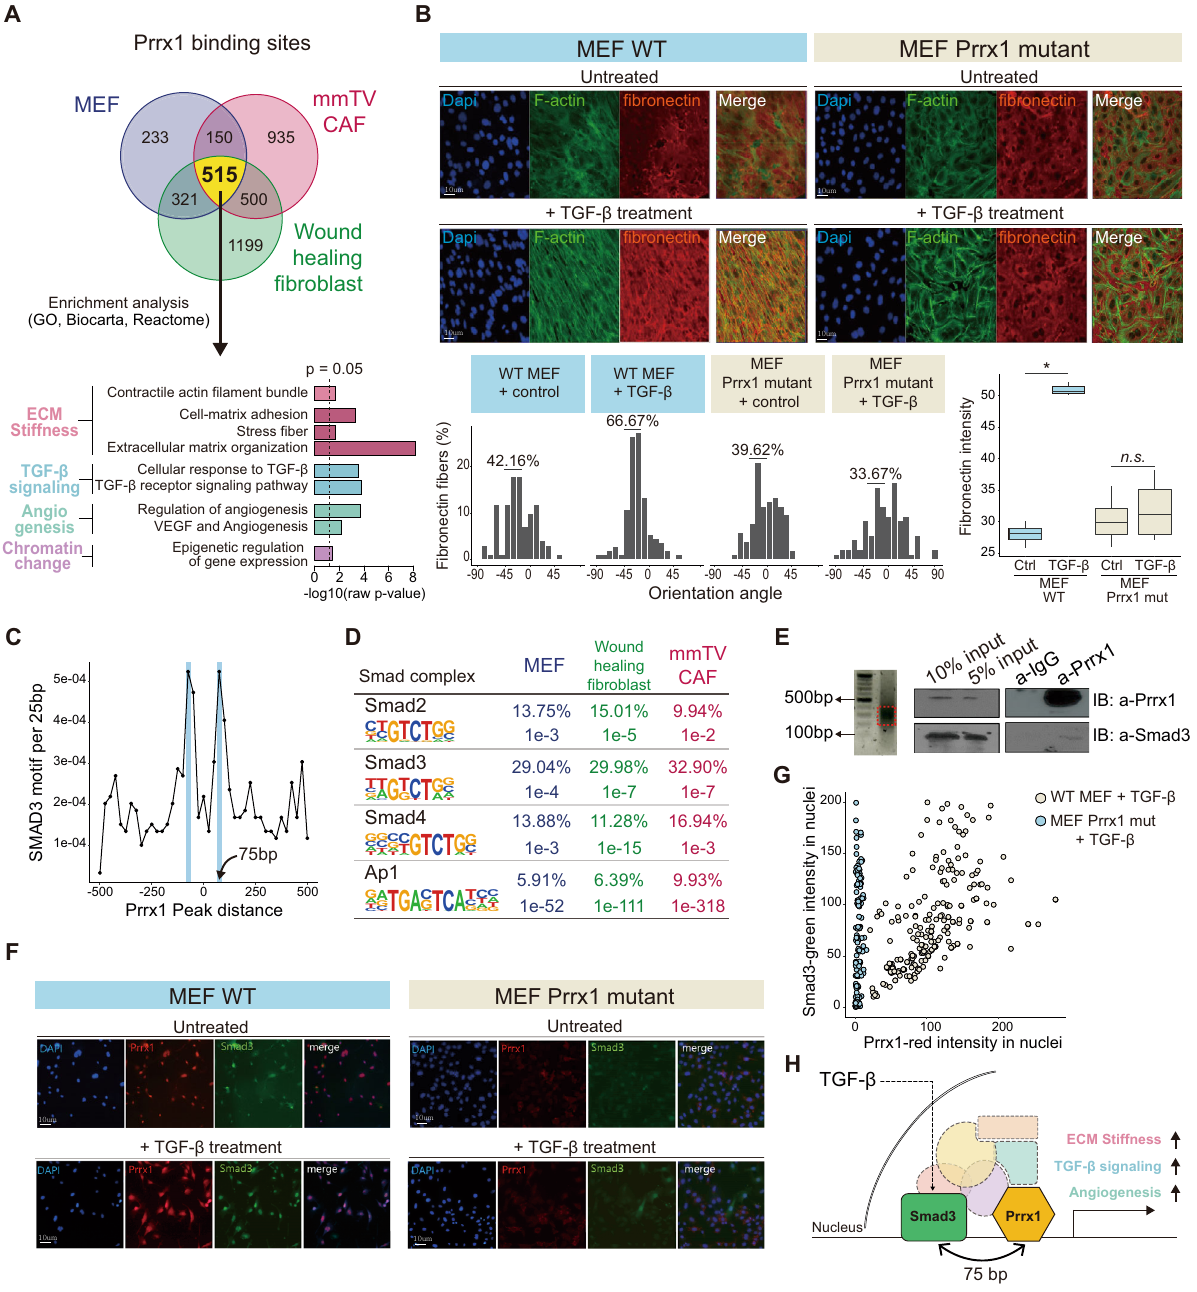
Fig. 5 Prrx1/Smad3 complex executes a myo fi broblastic program induced by TGF- β in fi broblasts. A Total 515 common binding sites of Prrx1 in three different fi broblasts by Prrx1 Chip-seq. The genes with TSS within 1 kb from the 515 binding sites were enriched in various pathways such as ECM remodeling, TGF- β , and angiogenesis pathways, which were features of activated cancer-associated fi broblasts. B 3D matrix remodeling capacity of MEFs depending on the presence of Prrx1 was assessed by the alignment of the cytoskeleton (F-actin) and ECM deposition ( fi bronectin). TGF- β mediated Prrx1- induced remodeling of. No exhibitions affected Prrx1-induced ECM remodeling in TGF- β untreated groups (Red: fi bronectin, Green: F-actin, Blue: DAPI). Box plot showing quanti fi cation of fi bronection intensity ( n = 6 independent experiments, * p < 0.0001 by two tailed t test). Data are presented as box-and- whisker plots indicating median (middle line) and minimum and maximum values (whiskers). C Predicted binding of Prrx1 and Smad3 at 75-bp interval between them using motif analysis. D Tables based on Prrx1 ChIP-seq motif analysis show that Prxx1 cobinds with Smad complexes. E Precipitation of Prrx1 after sonication of MEF genome 100 bp in length, con fi rmed that Smad3 was located near Prrx1. F , G Prrx1 and Smad3 were simultaneously expressed in the nucleus in the MEF WT group (Prrx1 normal expression) when TGF- β was treated with the MEFs, but not in the MEF Prrx1-mutant group (Impaired Prrx1 expression due to mutation). For ( E , F ): this experiment was independently repeated three times with similar results. H Schematic model of activated fi broblast induced angiogenesis, ECM stiffness, and TGF- β signaling via Prrx1-Smad3 complex. Source data and exact p values are provided as a Source Data fi